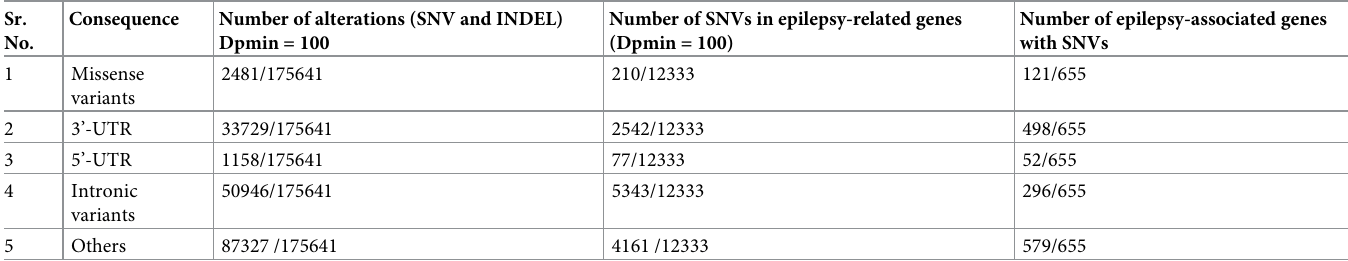
Table 1. Distribution of SNV’s into different consequences with a DP cutoff of 100. Sr.